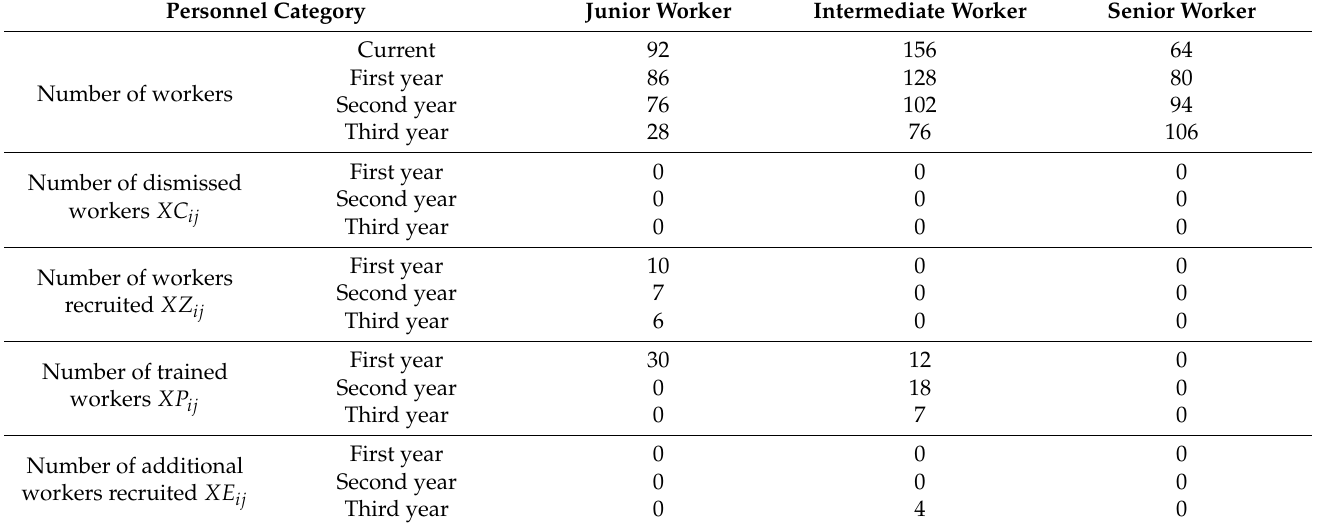
Table 8. Optimization of flow of workers in the minimum dismissal model for the past three years.